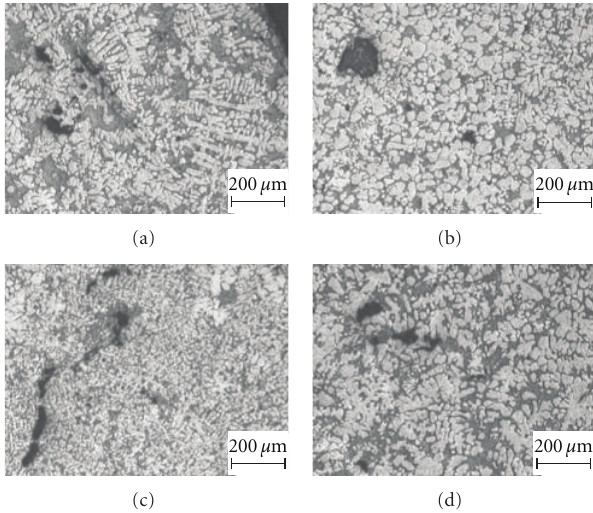
Figure 24: The microstructure of knuckle including defects such as porosity and segregation of liquid phase ( C : 60A; T s : 20s)